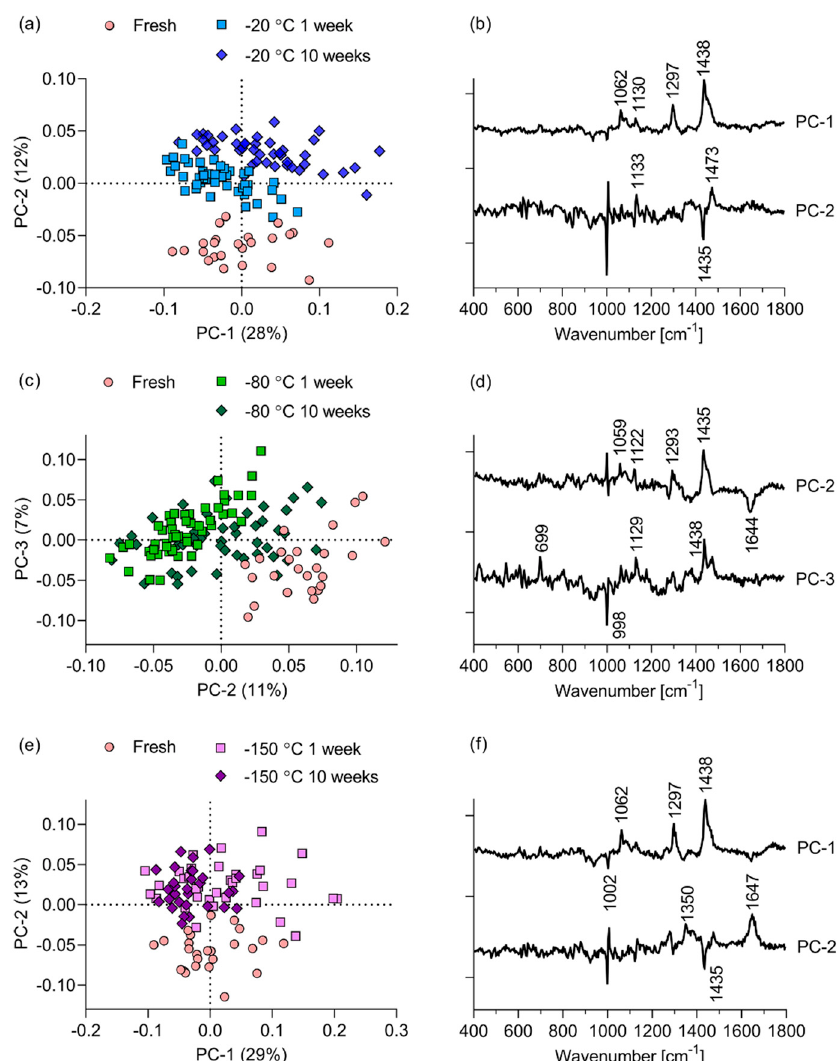
Figure 4. Score and loading plots for the first 2 components obtained from the PCA of fresh EpiSkin™ RHE vs. the RHE stored for 1 and 10 weeks at ( a , b ) − 20, ( c , d ) − 80, and ( e , f ) − 150 °C.